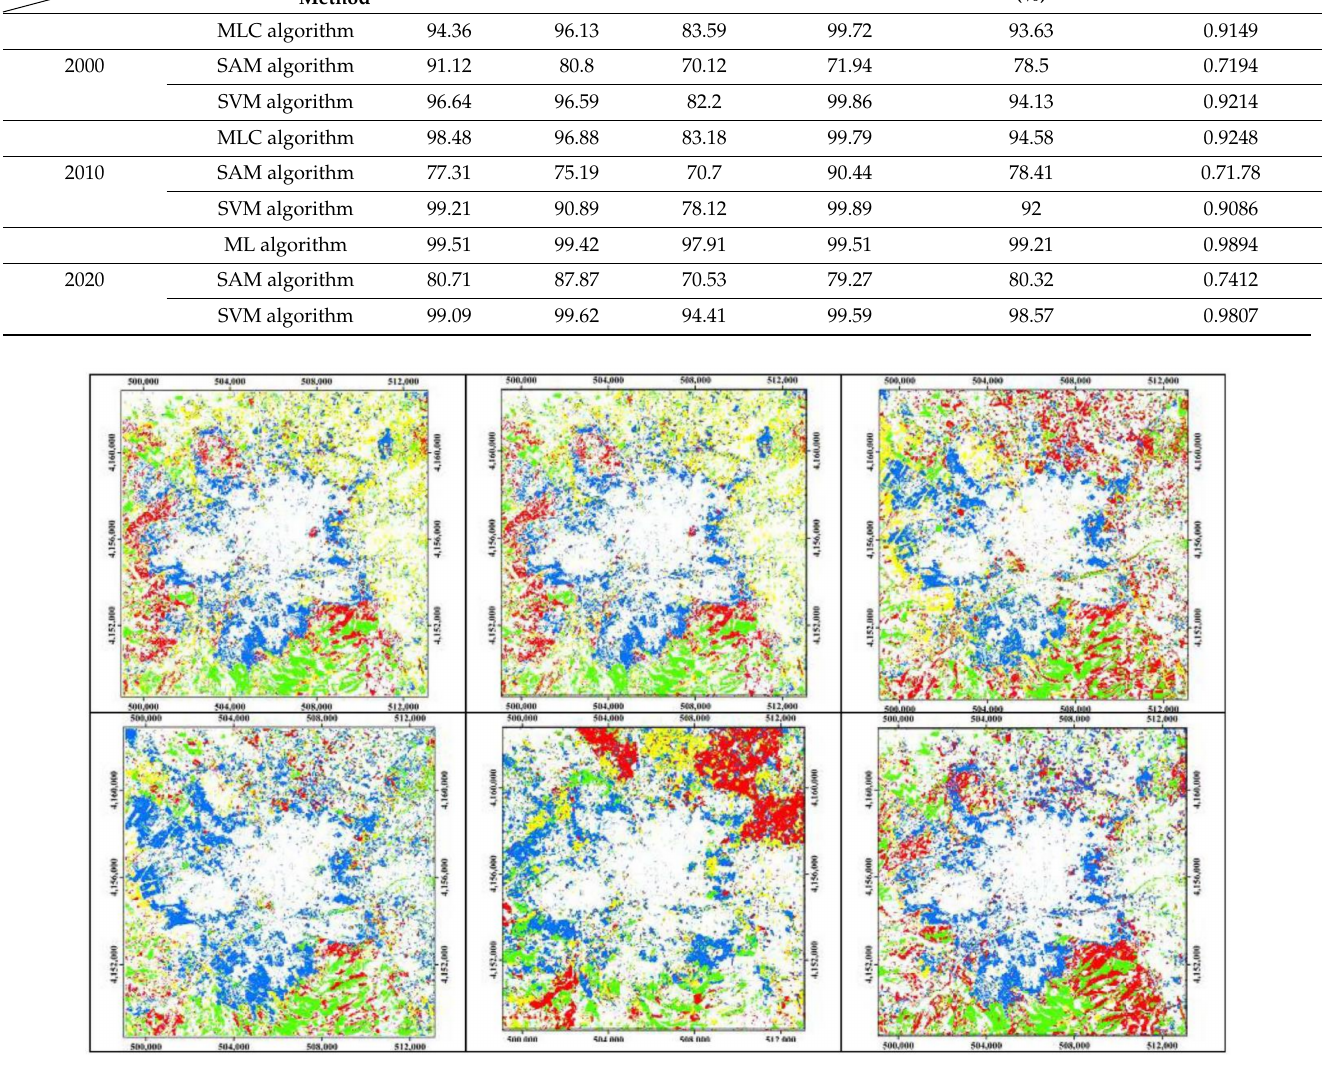
Figure 4. Change maps of 2000–2010 ( upper ) and 2000–2020 ( lower ) periods provided by MLC ( left ), SAM ( middle ), and SVMs ( right ) algorithms. White: No change, Blue: Converted to built-up, Red: Converted to rocky, Yellow: Converted to soil and Green: Converted to